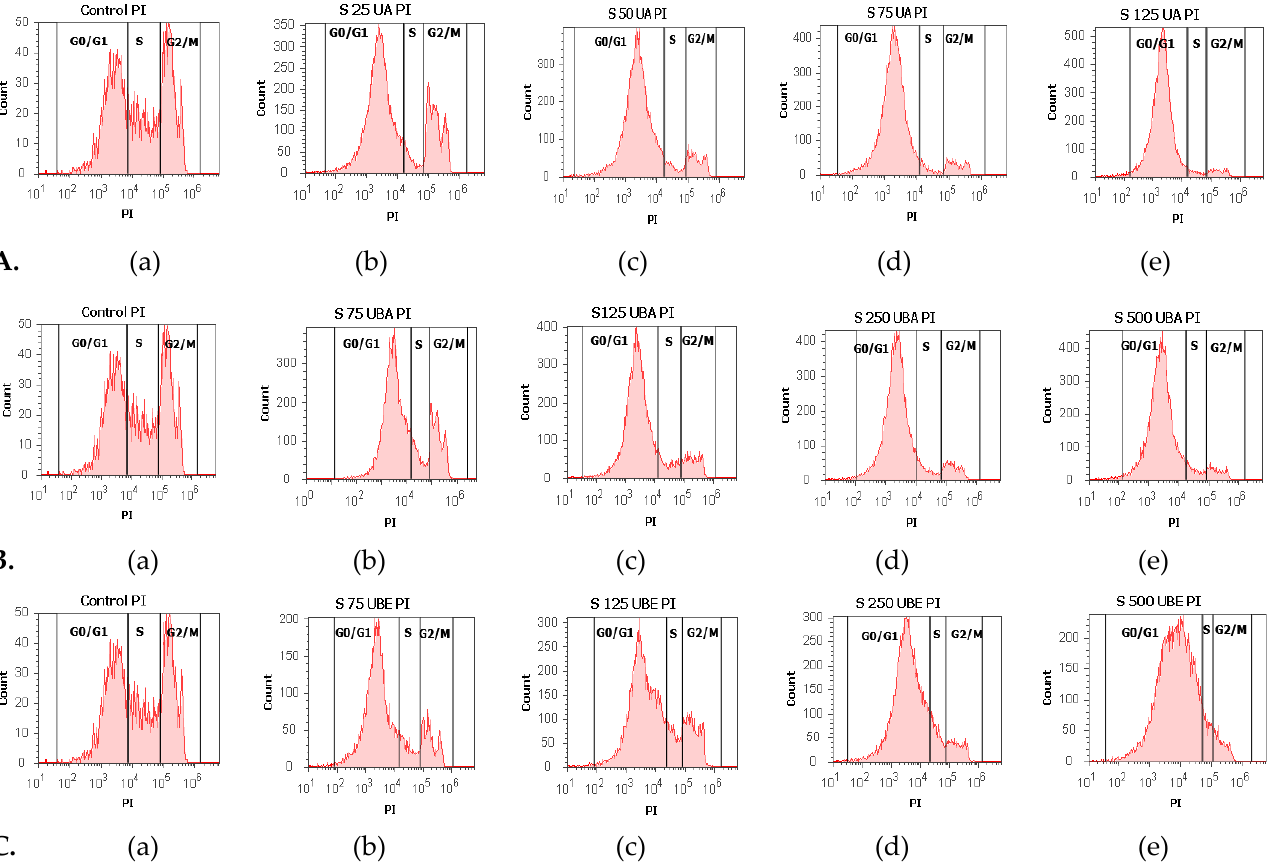
Figure 11. Cell cycle model of UA, UBA, and UBE treatments in normal blood cell cultures. PI/RNase A patterns of UA 25, 50, 75, 125 μ g/mL A ( b – e ); B ( b – e ) UBA 75, 125, 250, 500 μ g/mL; C ( b – e ) UBE 75, 125, 250, 500 μ g/mL reported to 1% DMSO (Negative Control, A ( a ), B ( a ), C ( a )).